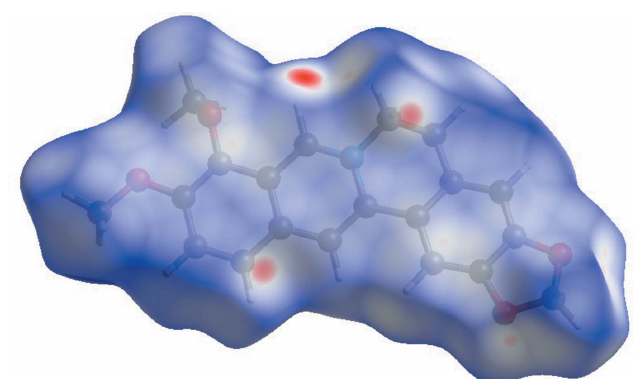
Figure 3 Hirshfeld surface for the berberine cation in the title structure plotted over d norm in the range (cid:3) 0.1877 to 1.1413 a.u.